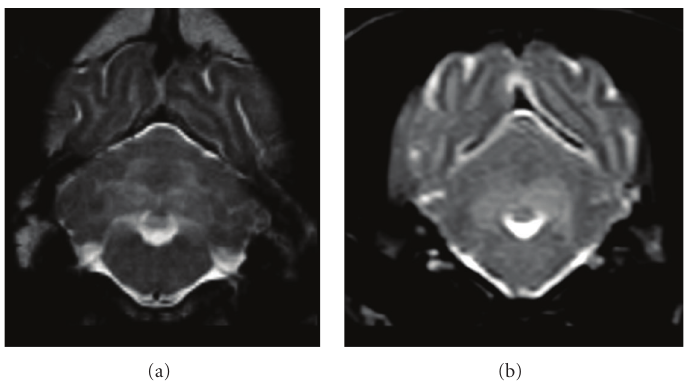
Figure 3: T2W hyperintensity in the white matter of the cerebellum (transverse image at the 4th ventricle level). (a) An a ff ected laboratory dog at 9 months of age. (b) Clinical case (animal 1) at 9 months of age.